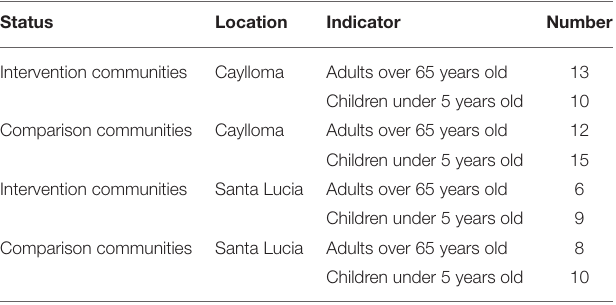
TABLE 1 | Interventions and comparison